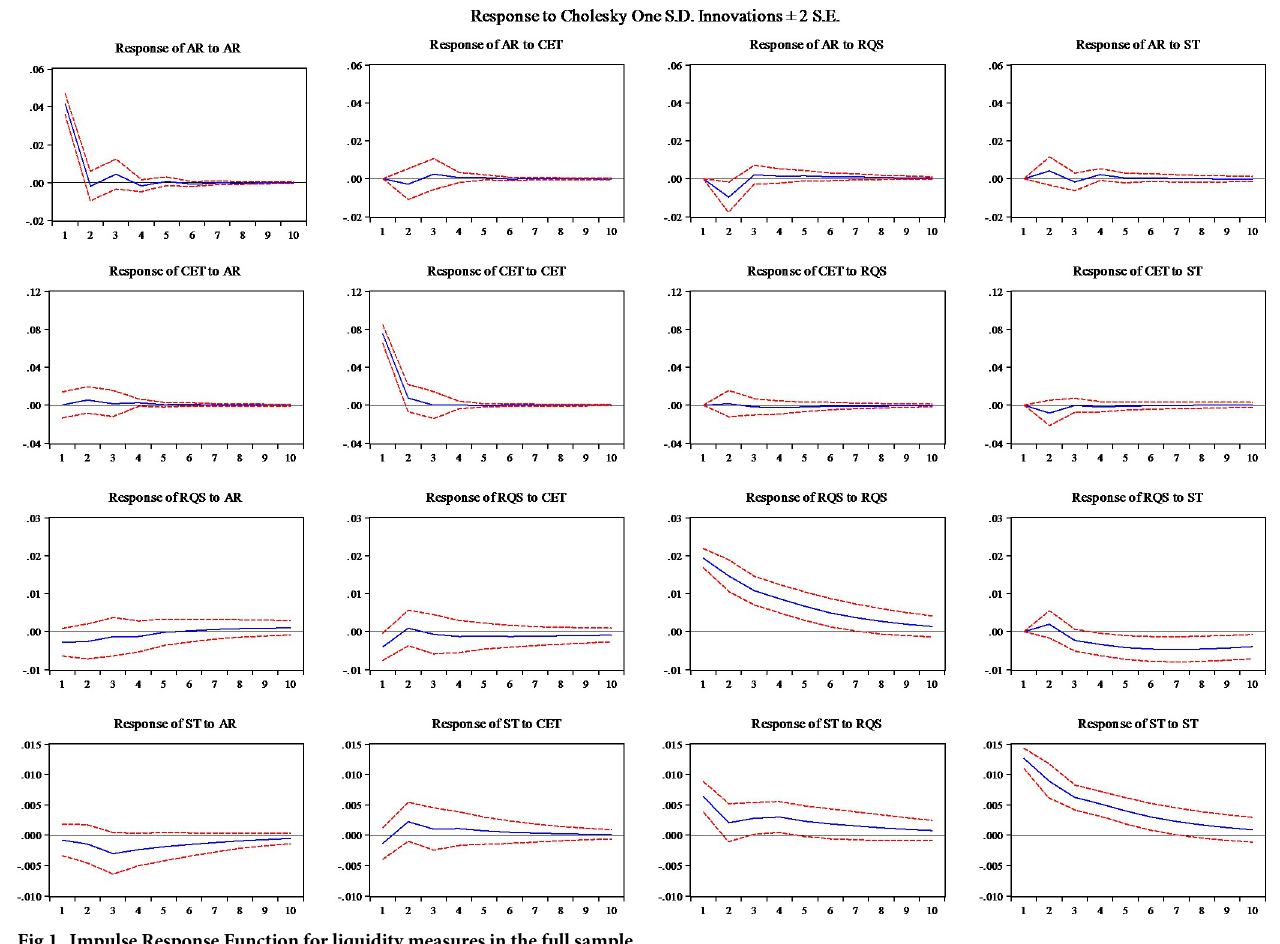
Fig 1. Impulse Response Function for liquidity measures in the full